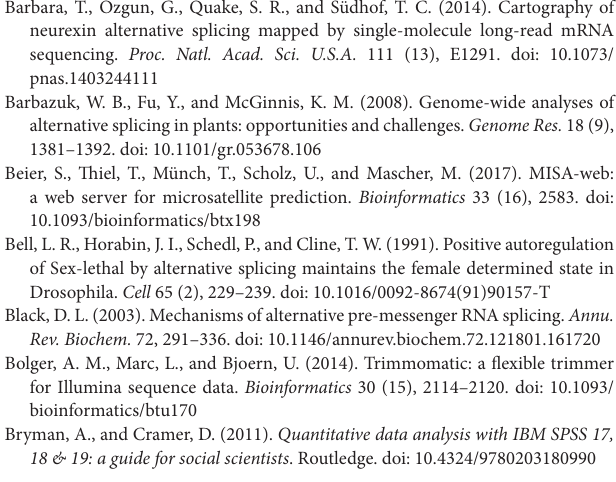
SUPPLeMeNTaRY FIgURe 1 | ROIs length distribution of three size bins. SUPPLeMeNTaRY FIgURe 2 | Examples of structures showing the gene with different types of isoforms. The blue bars indicated the annotated gene model in the L. maculatus genome. In (a) , the orange bars indicated the isoform structure detected by Iso-Seq. Lines represented introns, and arrows indicated the orientation of transcription. In (B) , novel gene and their transcripts were absent in the annotation of the genome. SUPPLeMeNTaRY FIgURe 3 | Examples of validation experiments for (a) novel isoforms, (B) APA event and (C) fusion transcripts. SUPPLeMeNTaRY FIgURe 4 | KEGG analysis of the genes with more than four isoforms. (a) KEGG pathway annotation; (B) Statistics of pathway enrichment. SUPPLeMeNTaRY FIgURe 5 | Examples of five types of alternative splicing events detected by Iso-Seq. The blue bars indicated the annotated gene model in the L. maculatus genome, and dark green bars indicated the transcripts structure detected by Iso-Seq. (a) Example of intron retention events in evm.TU.scaffold_294.3; (B) Example of exon skipping events in evm.TU.scaffold_229.19; (C) Example of alternative 3’ splice site events in evm.TU.scaffold_13.295; (e) Example of alternative 5’ splice site events in evm.TU.scaffold_81.120; (e) Example of mutually exclusive exon events in evm.TU.scaffold_98.14; SUPPLeMeNTaRY FIgURe 6 | Histogram of gene ontology classifications of L. maculatus fusion transcripts. SUPPLeMeNTaRY FIgURe 7 | Volcano plot showing the DETs between the FW and SW treatment groups. The horizontal axis was the log2 fold change in SW relative to FW groups. The vertical axis was the -log10 false discovery rate. Green dots represented significantly down-regulated transcripts in SW relative to FW group, while red dots represented significantly up-regulated transcripts. Black dots represented transcripts without significant expression difference between two groups. SUPPLeMeNTaRY FIgURe 8 | Pie chart showing frequencies of five types of alternative spliced events in DETs. SUPPLeMeNTaRY FIgURe 9 | The transcripts structures of DETs with opposite expression patterns generated from 7 genes. Blue bars indicated the annotated gene model in the L. maculatus genome, and orange bars indicated the transcripts detected by Iso-Seq. Transcripts with DETs were marked with red dashed